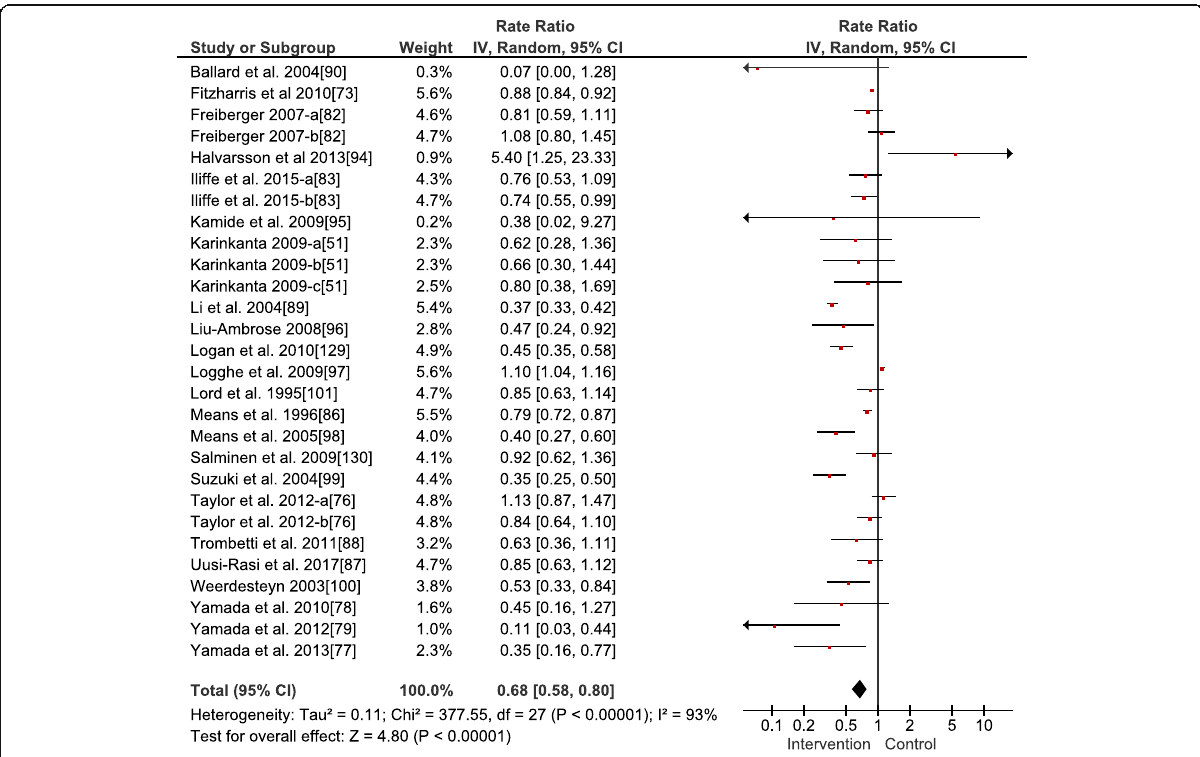
Fig. 2 Forest plot for the meta-analysis of the fall rate ( n =4334). An inverse variance (IV) analysis was performed, and the 95% confidence interval (CI) is provided. The studies followed by the letters a or b or c mean that they include different intervention groups, and each letter resembles one intervention